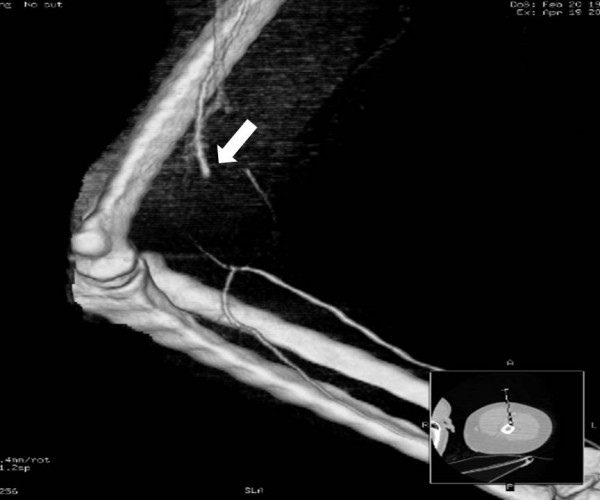
Same case as in figures 3, 4. CT-angiography with 3D-reconstruction demonstrating a 4 to 5 cm long brachial artery laceration at the elbow (arrow) with reconstitution of forearm vessel flow via collateral perfusion.